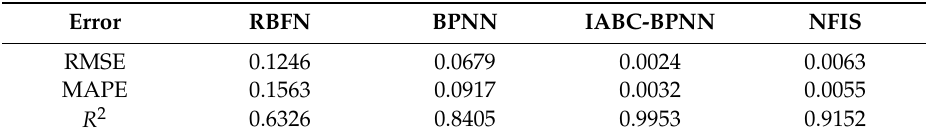
Table 4. The errors of the compared